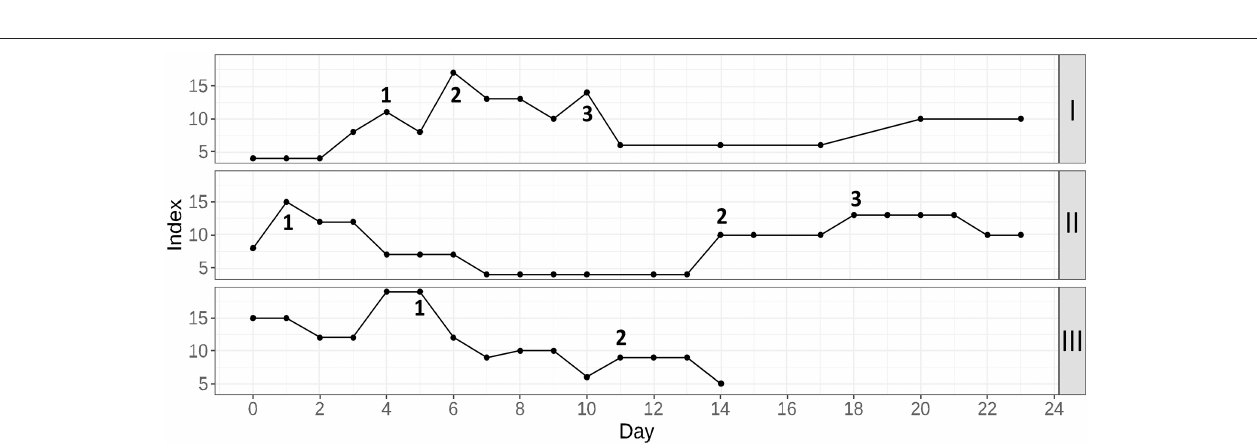
FIGURE 5 | Five risk grades based on the proposed prognostic score: very low (death: discharge odds < 1:100), low (1:100–1:25), average (1:25–1:5), high (1:5–1:1), and very high ( > 1:1).